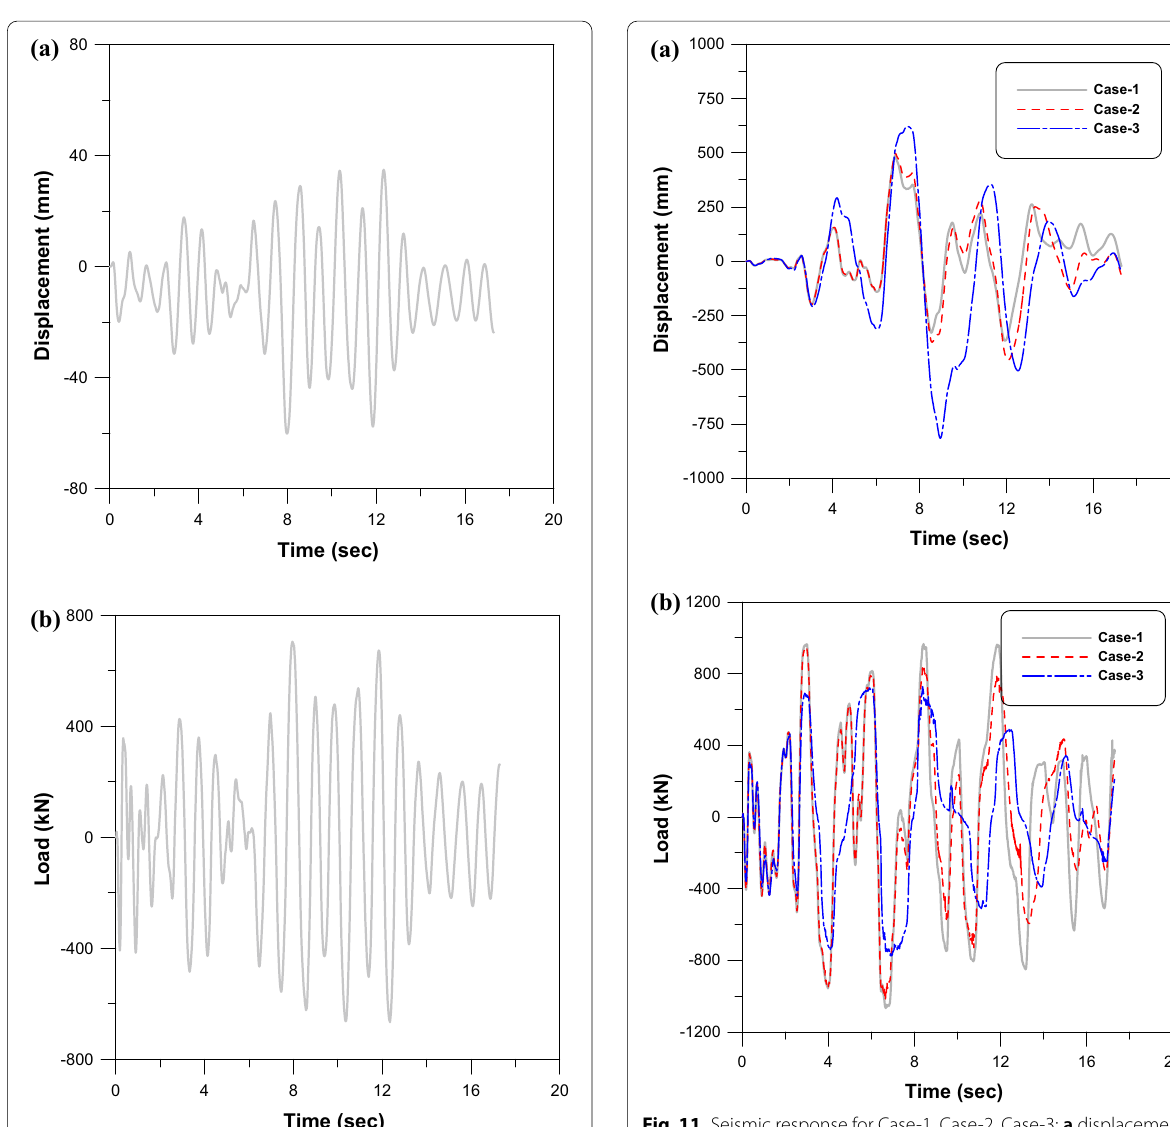
Fig. 10 Seismic response with RCAHEST: a displacement and b load.